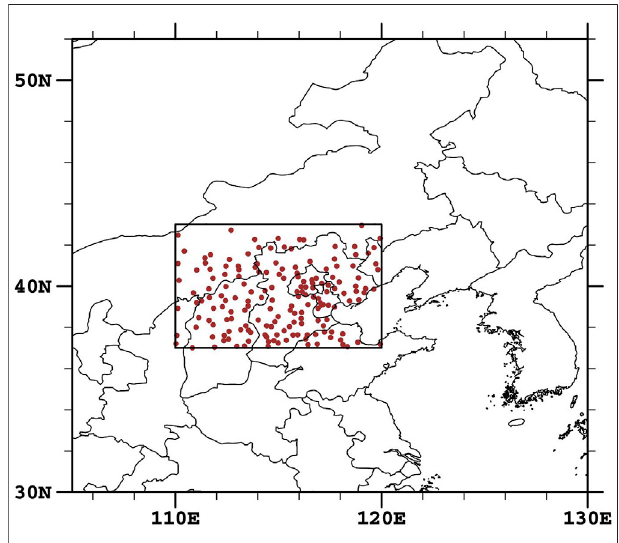
FIGURE 1 | Location of stations (dots in a rectangle) in North